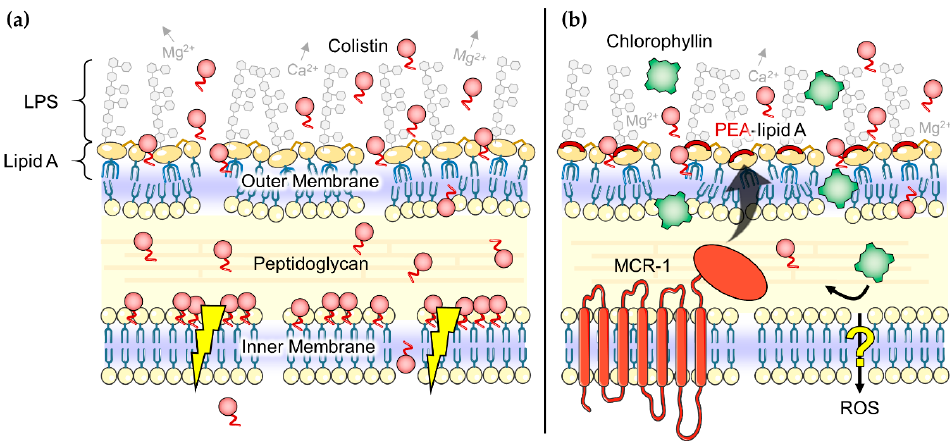
Figure 8. ( a ) Postulated effects of colistin (red circles) on Gram-negative bacteria. Colistin molecules disorganize the outer membrane and may somehow disrupt the physical integrity of the inner membrane (flash symbols) finally leading to cell death [75]; ( b ) Hypothesized ‘door opener’ effect of colistin for photodynamic treatment with chlorophyllin (green squares). The fatty-acyl tail is still able to perturb the outer membrane but effects on the inner membrane seems to be impaired by the protein MCR-1. Our data suggests that MCR-1 inhibits the uptake of chlorophyllin over the inner membrane (no inactivation of bacteria in the dark) but might allow the passing of chlorophyllin’s photodegradation products such as ROS (inactivation in light). LPS: lipopolysaccharides, PEA: phosphoethanolamine, ROS: reactive oxygen species. Parts of the figure were drawn by using pictures